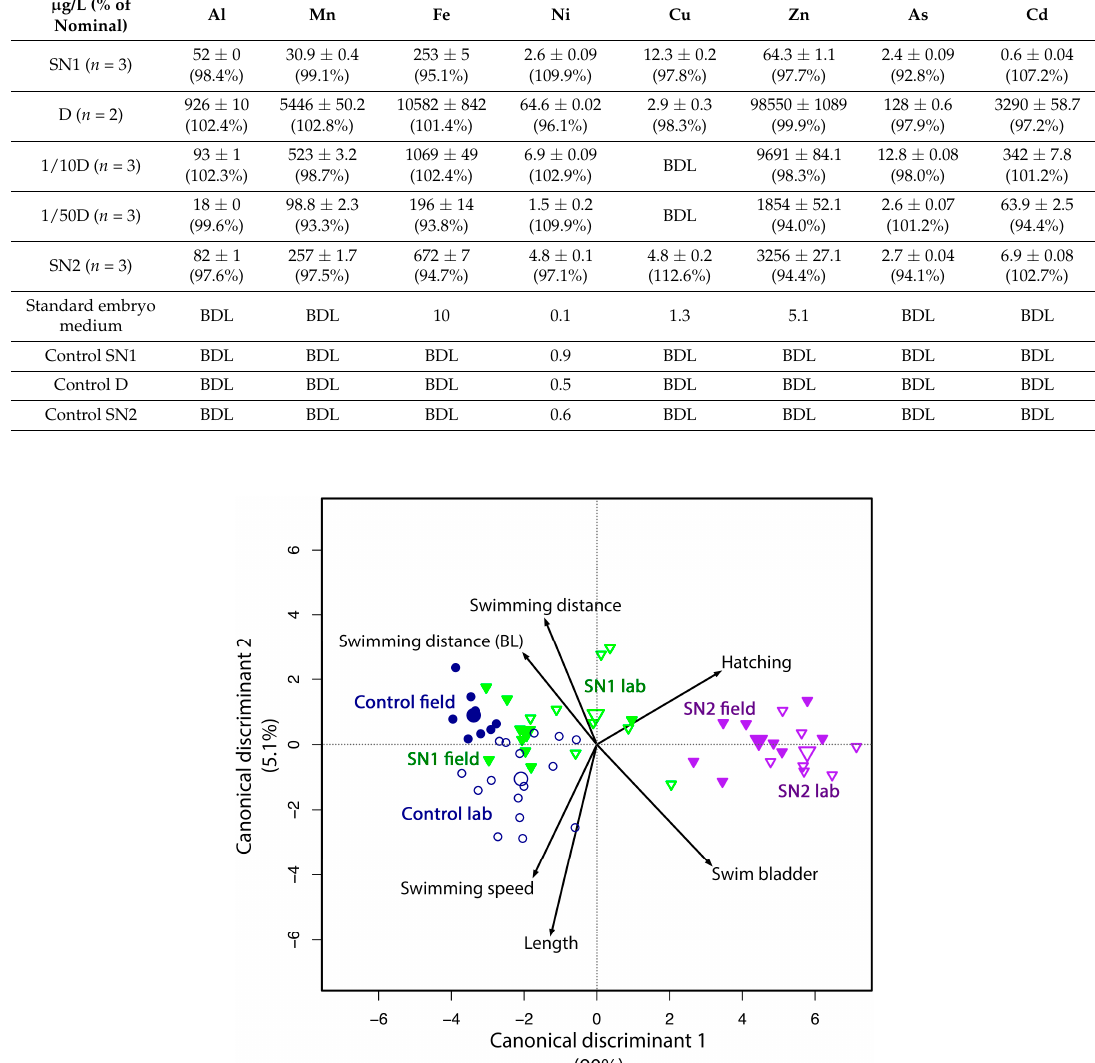
Table 3. Average metal (loid) concentrations ± standard deviation (SD) after addition of the reconstituted mixtures to the wells. BDL = below detection limit. Standard embryo medium was used as a negative and internal control. Sampling points are in the same sequence as the contamination gradient.